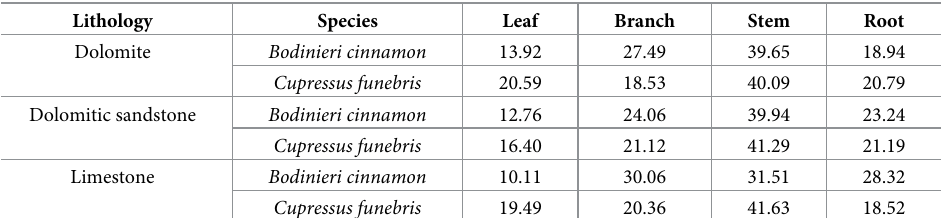
Table 13. Biomass of organs in the tree layer as a percentage of total biomass